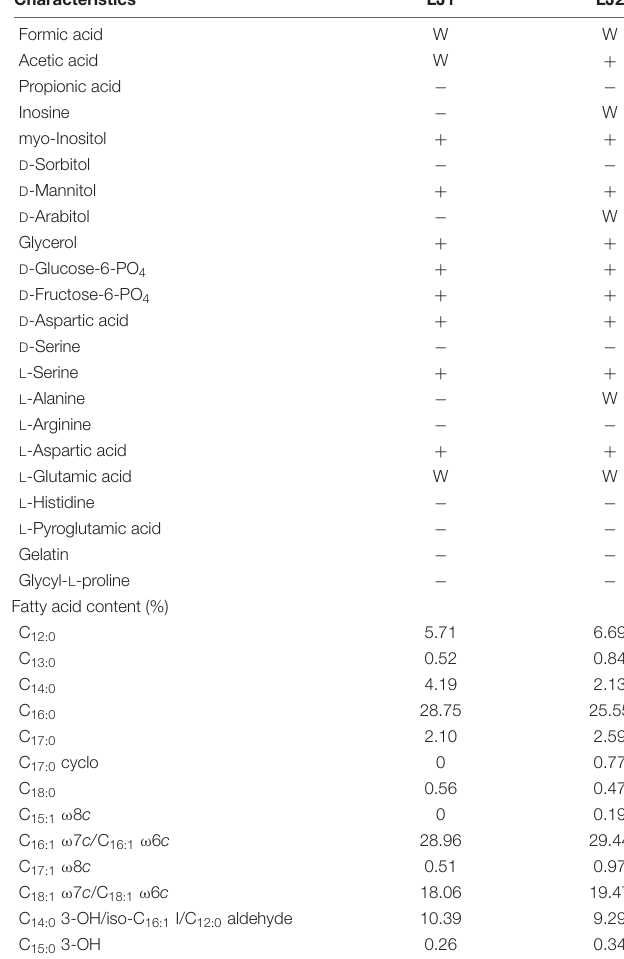
TABLE 2 | Phenotypic characteristics of strains LJ1 and LJ2.